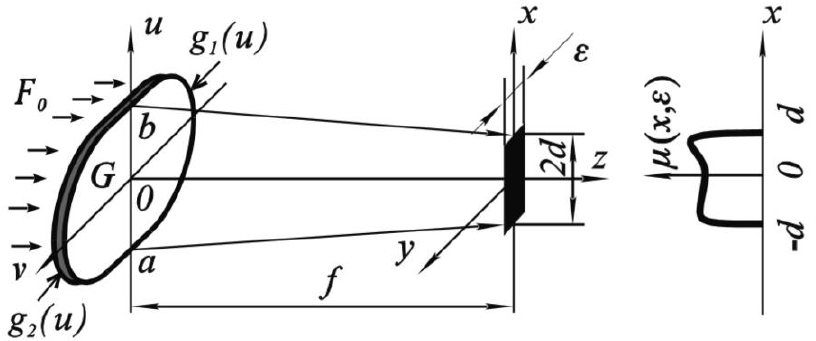
Figure 3. Focusing scheme of a laser beam with a geometry represented in two dimensions